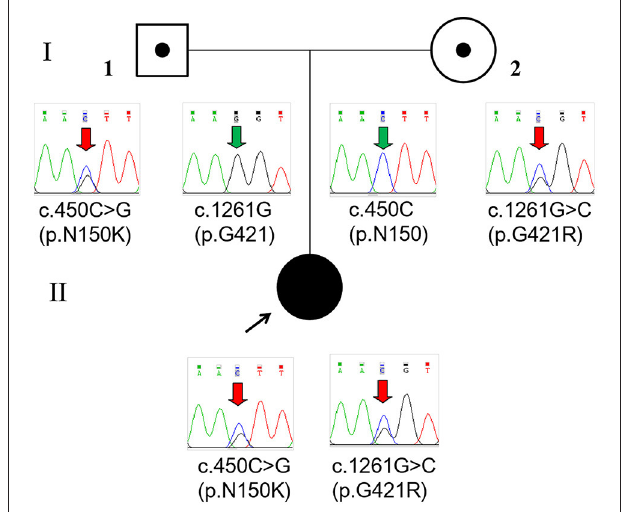
FIGURE 2 | Pedigree and GLDC variations confirmed by Sanger sequencing of the family. The patient (II) had a compound heterozygous